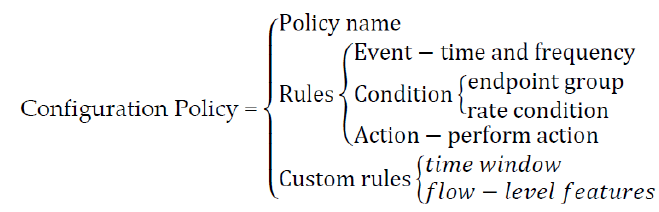
Figure 5. Advanced Configuration